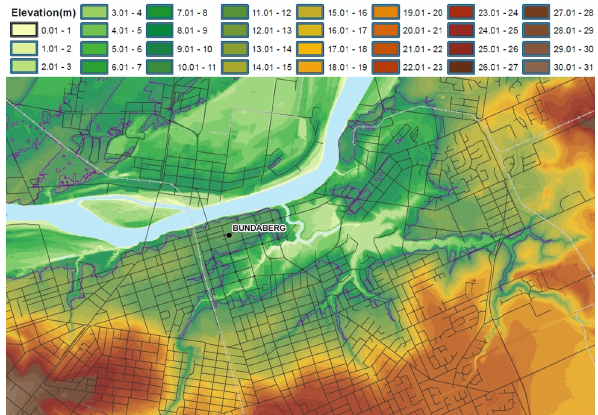
Figure 2. Bundaberg ground elevation (Bundaberg Regional Coun- cil, 2013a).